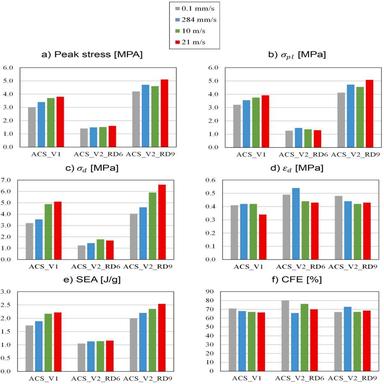
Comparison of the basic mechanical properties of ACS subjected at different loading velocities.